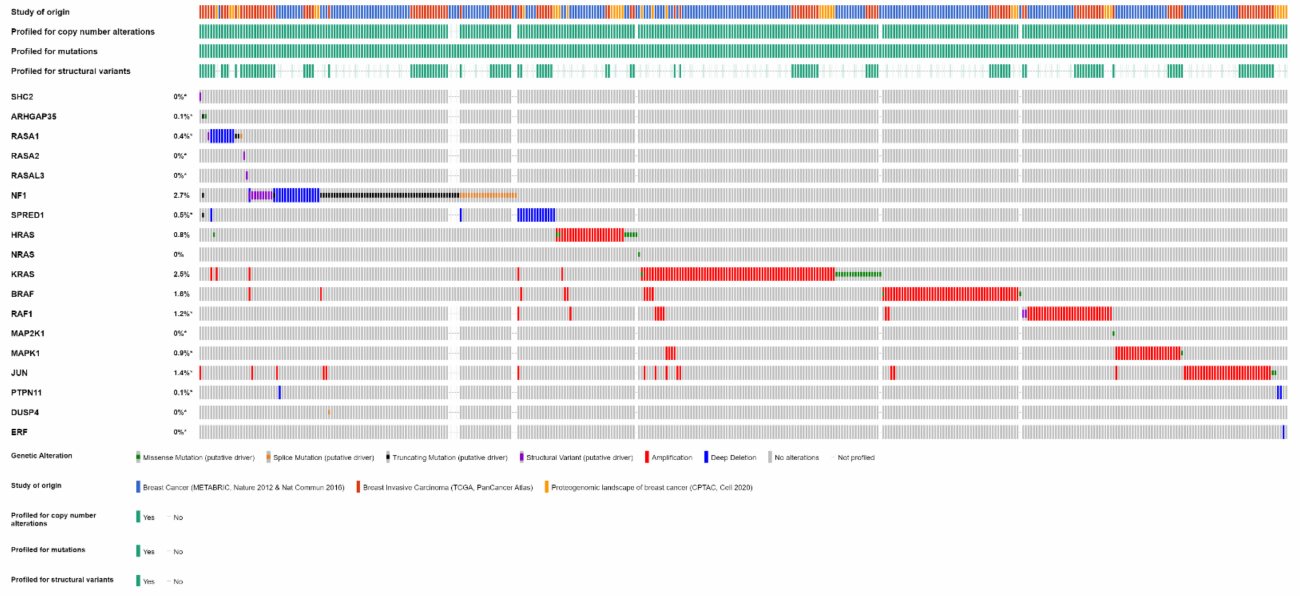
Figure 3. Alterations of RAS/RAF/MEK/ERK pathway genes in primary breast cancer samples of 3712 patients from three studies (METABRIC, TCGA, CPTAC) (OncoPrint from cBioPortal). The frequencies of gene alterations in different breast cancer subtypes, calculated on 2859 patients with available data, are reported in Figure 4. The proportion of alterations of KRAS and BRAF differed significantly among breast cancer subtypes (Fisher exact test two-sided p = 1.566 × 10 − 12 and p = 1.355 × 10 − 11 , respectively), with both genes more frequently altered, mainly due to amplification, in basal-like tumors.